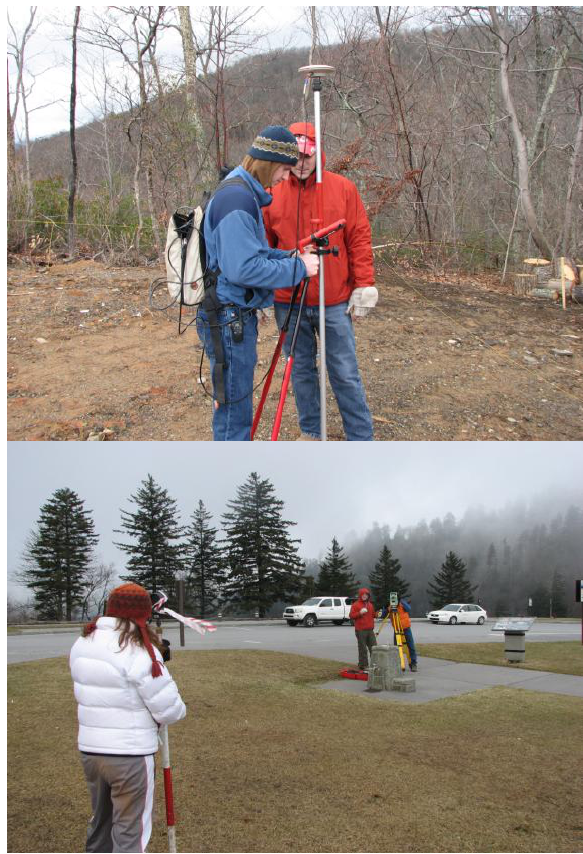
Figure 3 : Ground survey was conducted using a combination of DGPS and total station survey methods.